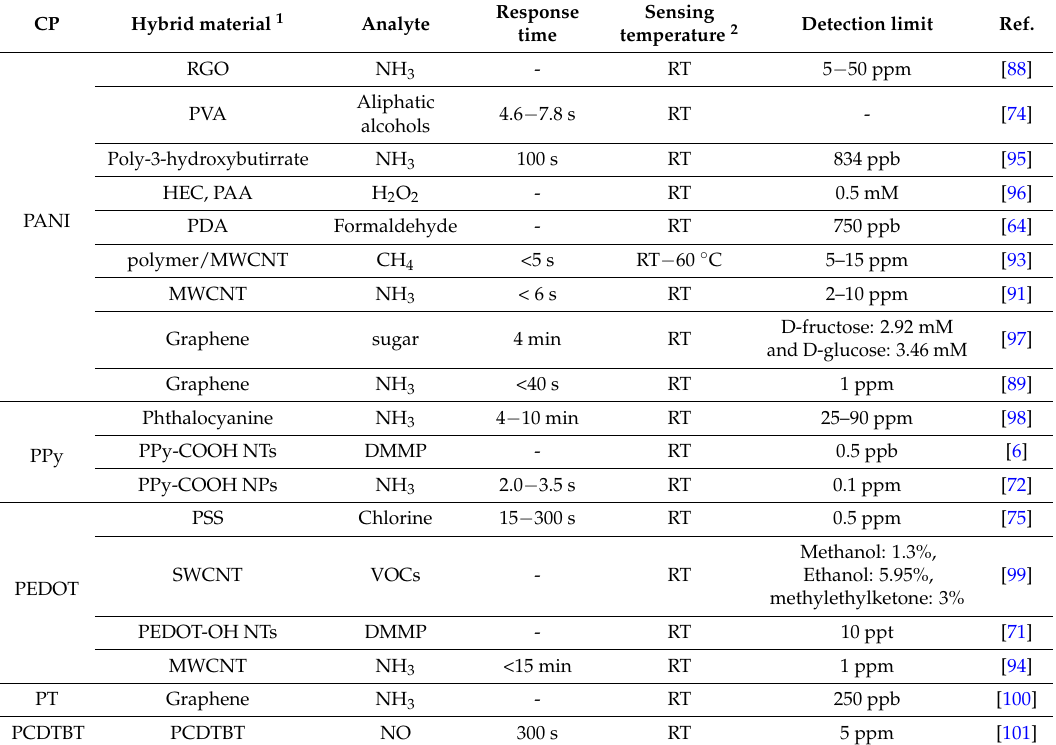
Table 2. CP organic hybrid composites used in gas